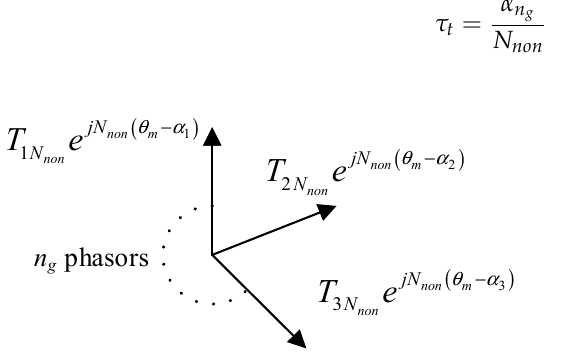
Figure 12. The phasor of cogging torque for n g group tooth.